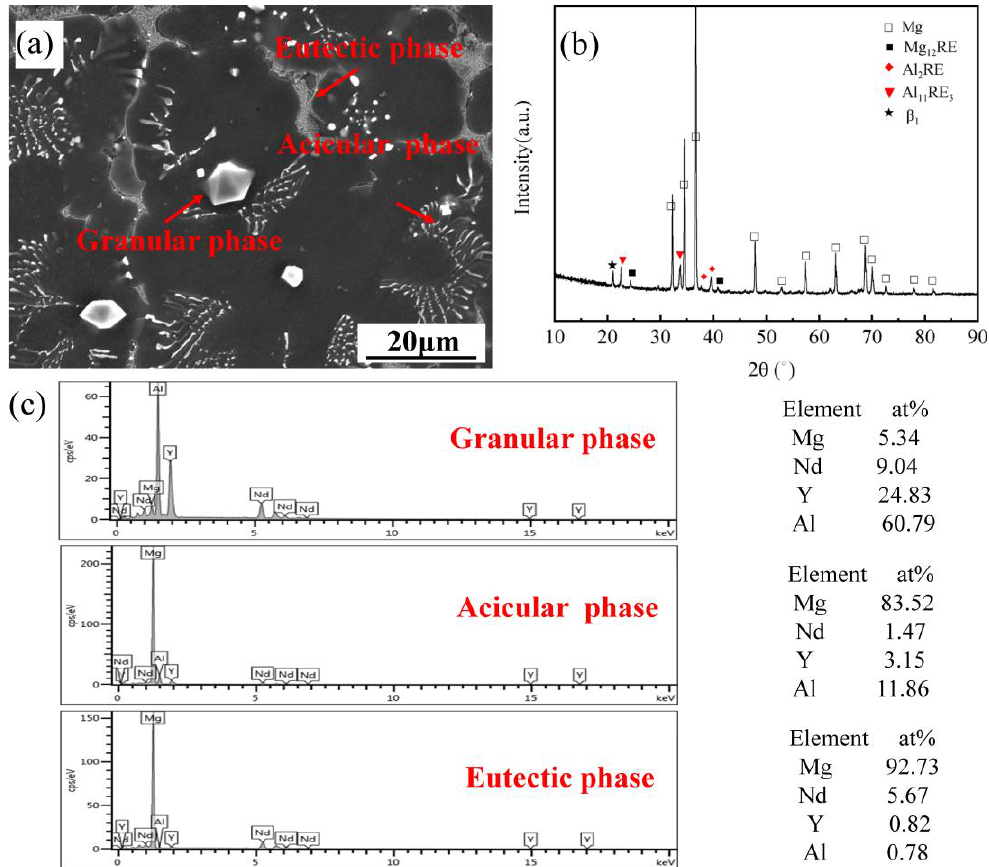
Figure 1. As-cast Mg-3Y-4Nd-2Al alloy: ( a ) SEM, ( b ) XRD pattern, and ( c ) EDS mapping.